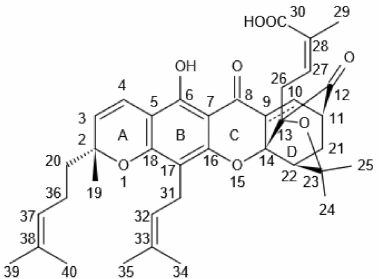
Figure 2. Structure of Gambogic acid